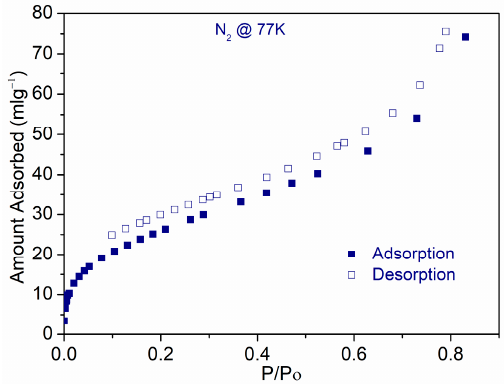
Figure 5. Low temperature nitrogen gas isotherm for IPM_325p3 at 77 K.